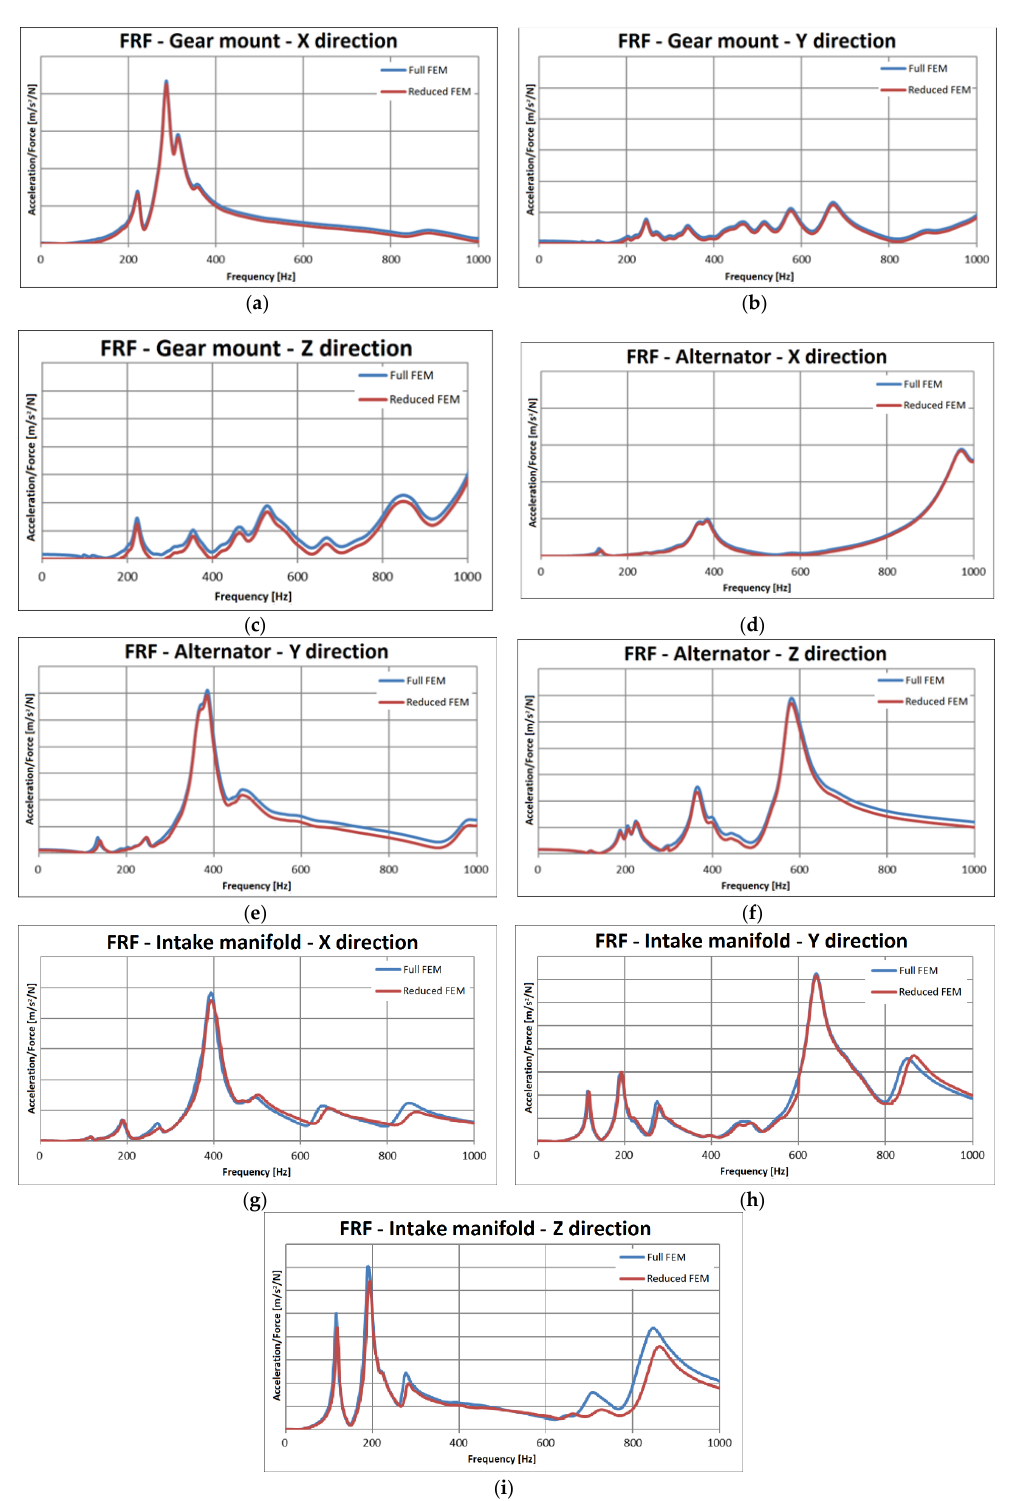
Figure 15. Comparisons of the acceleration/force ratio in the three directions for the full and reduced models at: ( a – c ) gear mount; ( d – f ) alternator; ( g – i ) intake manifold. models at: ( a – c ) gear mount; ( d – f ) alternator; ( g – i ) intake